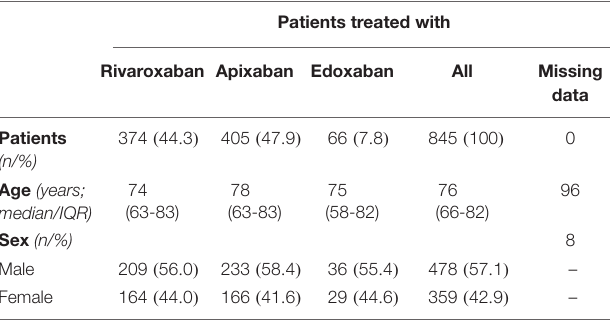
TABLE 1 | Characteristics of patients treated with rivaroxaban, apixaban or edoxaban ( n = 845). Patients treated with